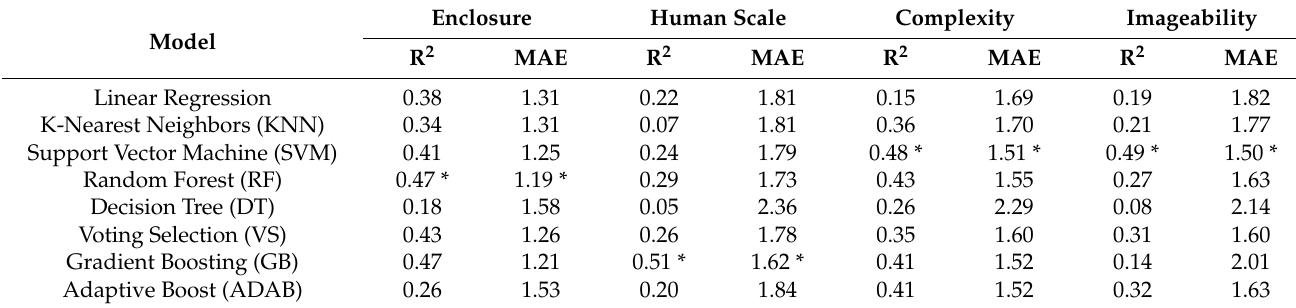
Table 2. Performance of machine learning algorithms.